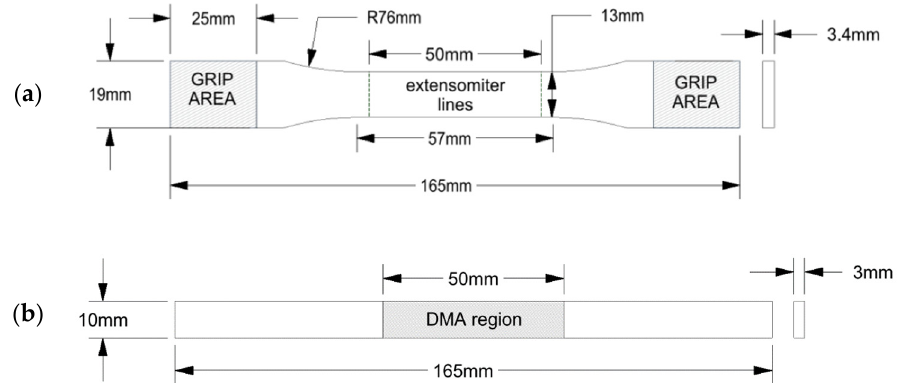
Figure 3. Sample geometries: ( a ) S TR geometry according to the type I of ASTM D638-14 standard, designed for the tensile test, and ( b ) S DMA geometry, according to ASTM D4065-20 standard, designed for the DMA, with tested regions highlighted (see Section 2.9).